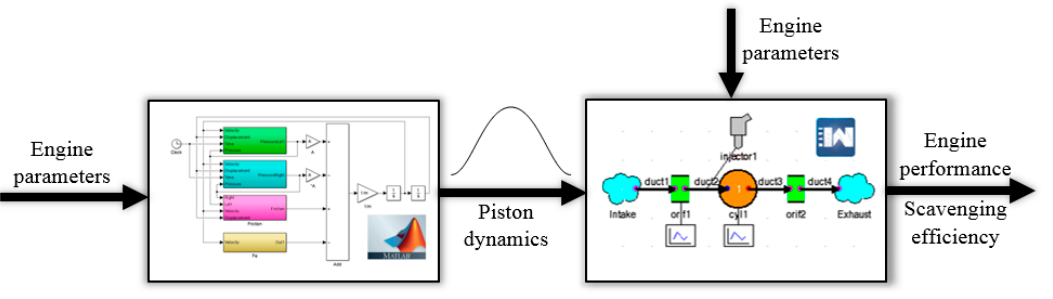
Figure 7. Simulation process.